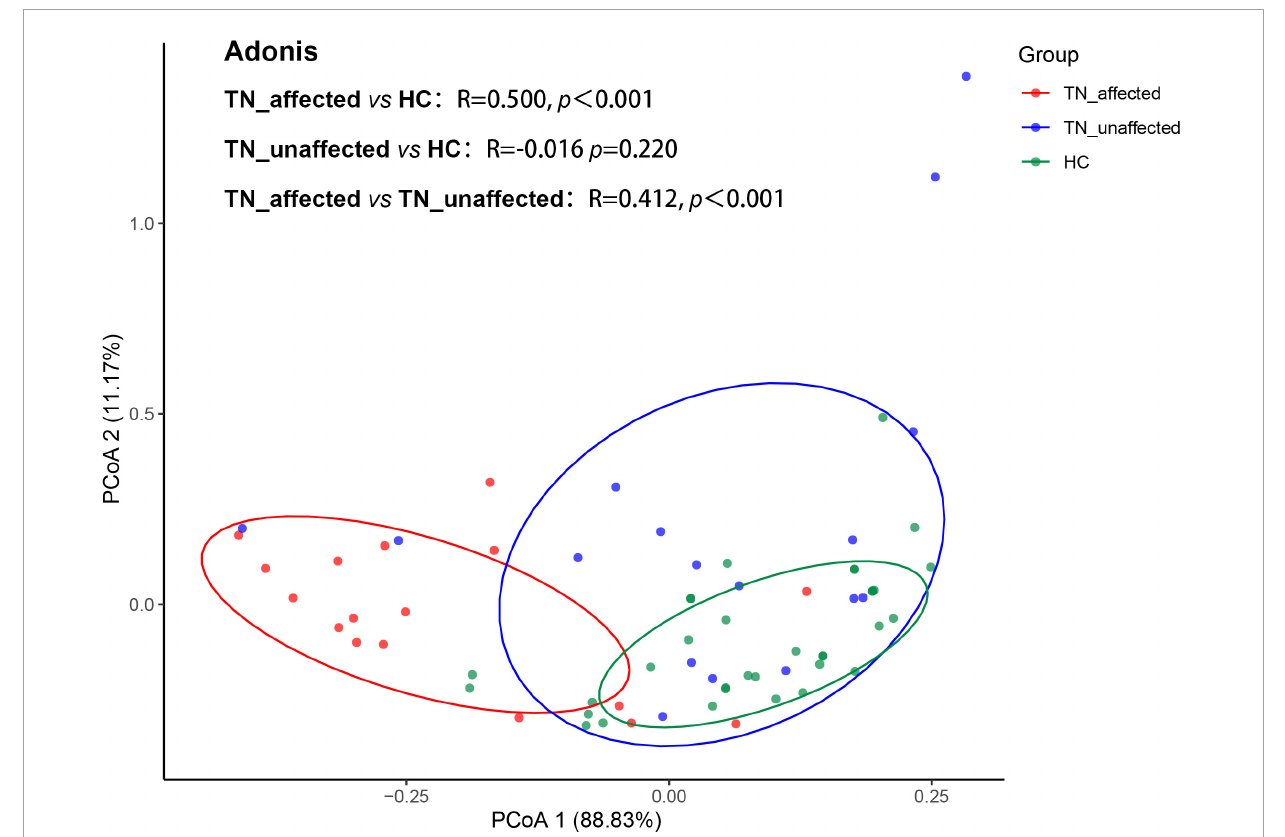
FIGURE4 Principal coordinates analysis (PCoA) of the affected side (TN_affected), unaffected side (TN_unaffected) in the PTN group and HC group showed significant differences in the four DTI indicators between TN_affected and HC groups ( r = 0.500, p < 0.001) and TN_affected and TN_unffected groups ( r = 0.412, p < 0.001), but no significant differences between TN_unaffected and HC groups ( r = –0.016, p =